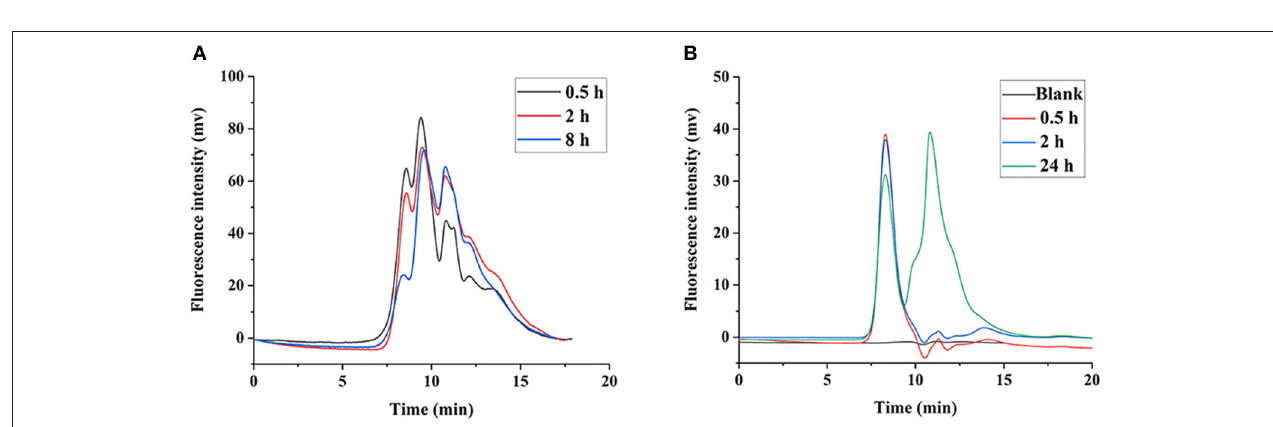
FIGURE 6 | Degradation of FLNT in liver. (A) Degradation of FLNT at different time points in liver in vivo . (B) Degradation of FLNT at different time points in liver homogenate in vitro